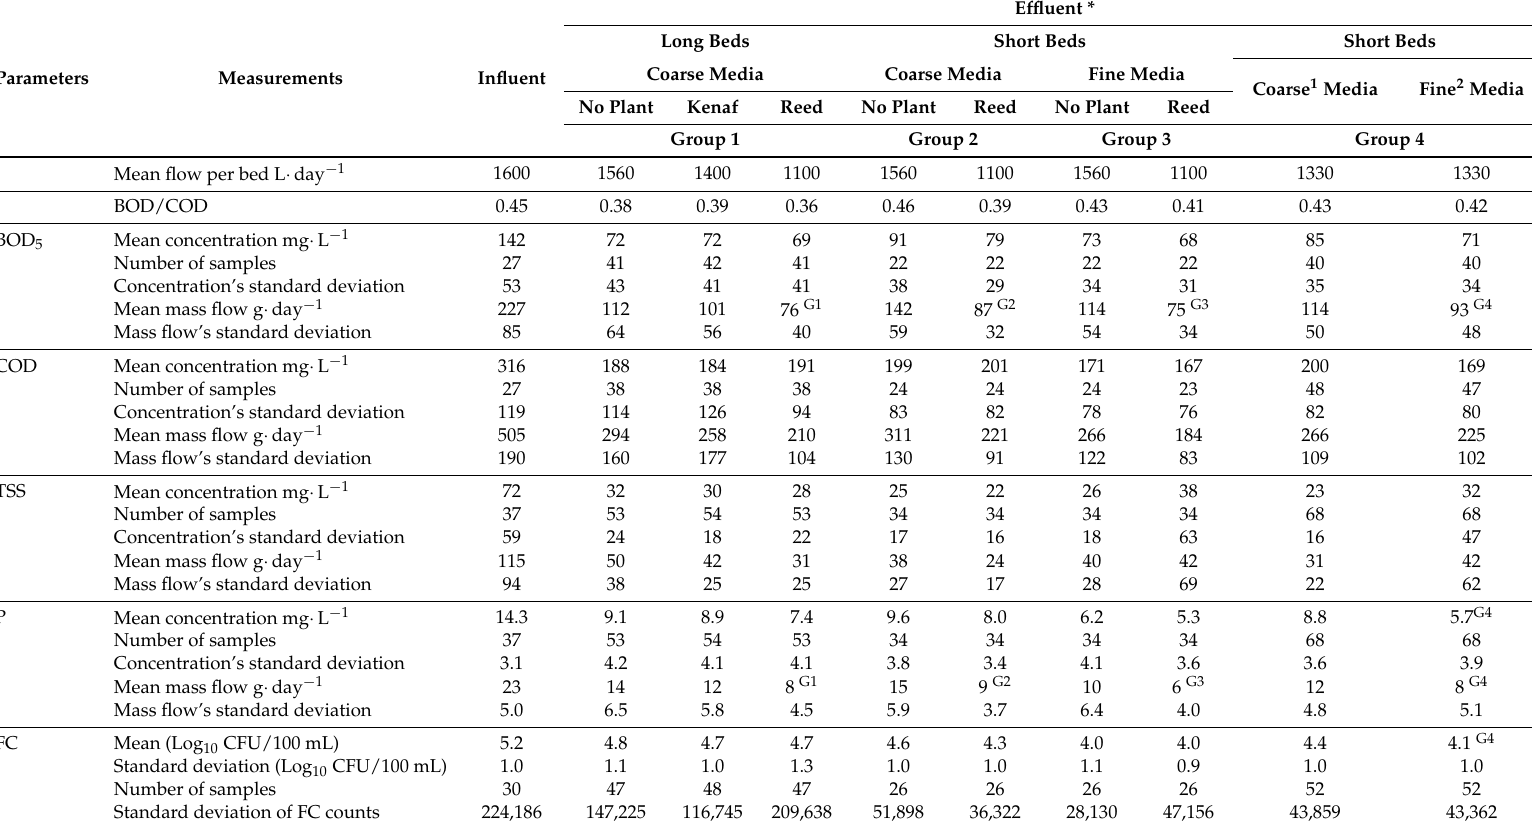
Table A1. The results of BOD 5 , COD, TSS, and P concentration, mass flow, fecal coliform count, and BOD 5